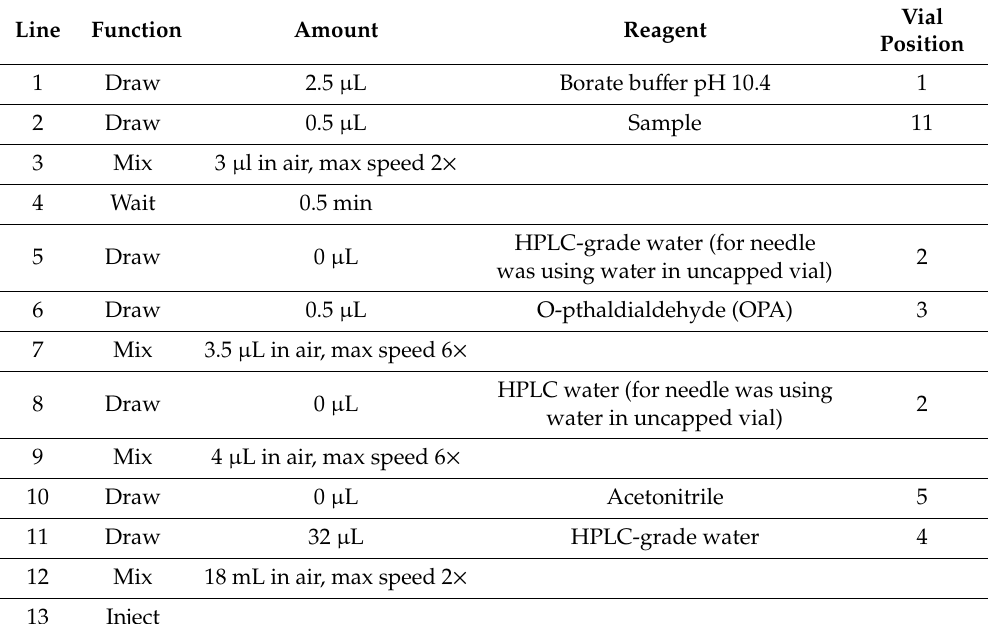
Table 2. Injector program.